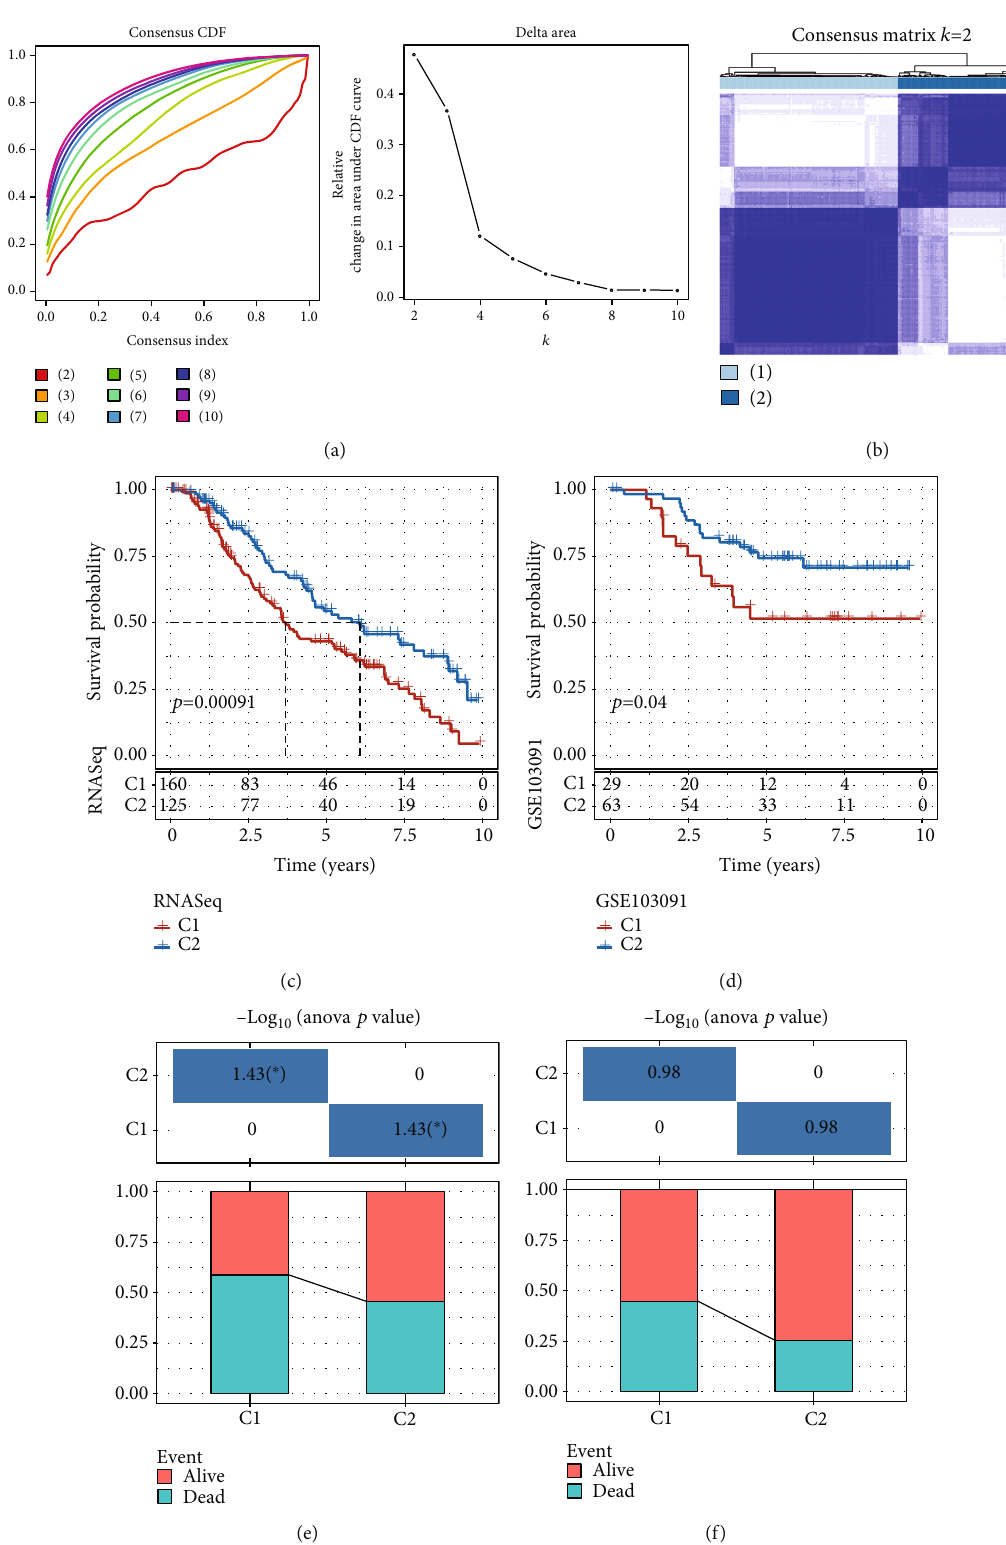
Figure 1: Consensus clustering analysis considering the prognosis of TNBC cell necroptosis-linked genes. (a) The CDF of di ff erent clustering methods for k -values ranging between 2 and 10. The relative change of the CDF AUC curve was determined for 2 to 10. (b) TNBC samples with clustering heatmap index k = 2 of RNAseq. (c) KM curve for the prognosis of necroptosis clusters in the RNAseq data set. (d) KM curve of OS between two clusters of necroptosis in GSE103091 cohort. (e) Subtypes ’ di ff erent survival status in the RNAseq data set. (f) Subtypes ’ di ff erent survival status in GSE103091 is di ff